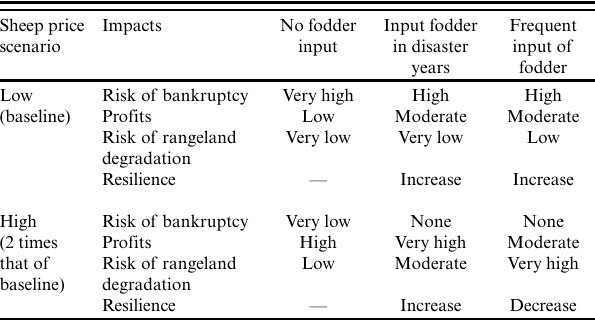
Table 4 . Summary of the impacts of fodder strategies at different levels of fodder